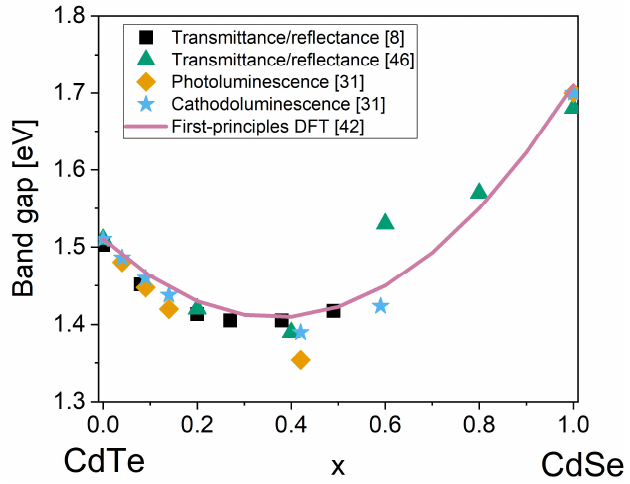
Figure 1. Band gap bowing of CdTe 1− x Se x measured by different methods [8,31,46] and calculated from first-principles DFT [42]. Table 1. Band gap bowing parameters of layers and powders synthesized with different methods.